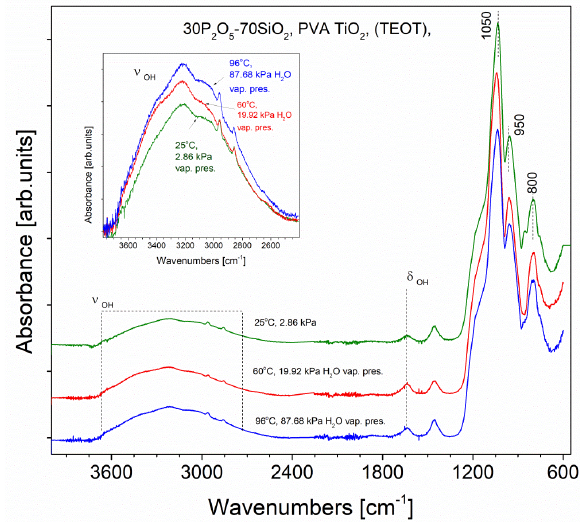
Figure 7. FTIR ATR spectra recorded for the sample RL59 held in an increasing water vapour pressures: 2.86 kPa achieved in a temperature 25 °C with no additional humidification; 19.91 kPa achieved in a temperature of 60 °C and 87.68 kPa in temperature of 96 °C.